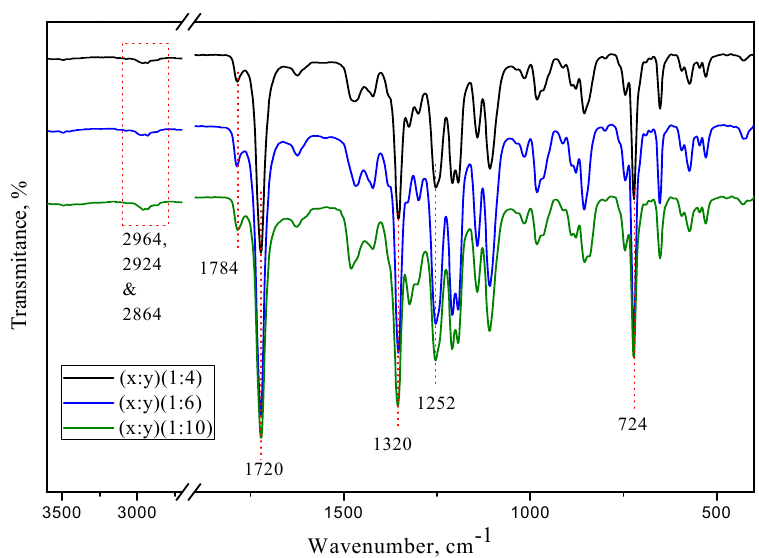
Figure 2. ATR-FTIR spectra of the [(PIM-PI) x -(6FDA-durene-PI) y ] copolymers with three different PIM-PI compositions (x:y = 1:4, 1:6 and 1:10). The molecular weights (M w ) of the three [(PIM-PI) x -(6FDA-durene-PI) y ] copolymers were determined by gel permeation chromatography (GPC), and were found to be in the range 43 − 49 kDa, supporting the achievement of copolymerization (Table 1). Table 1. Various physical properties of the [(PIM-PI) x -(6FDA-durene-PI) y ] copolymers, 6FDA-durene PI and PIM-PI-1 homopolymerandtheir corresponding membranes .